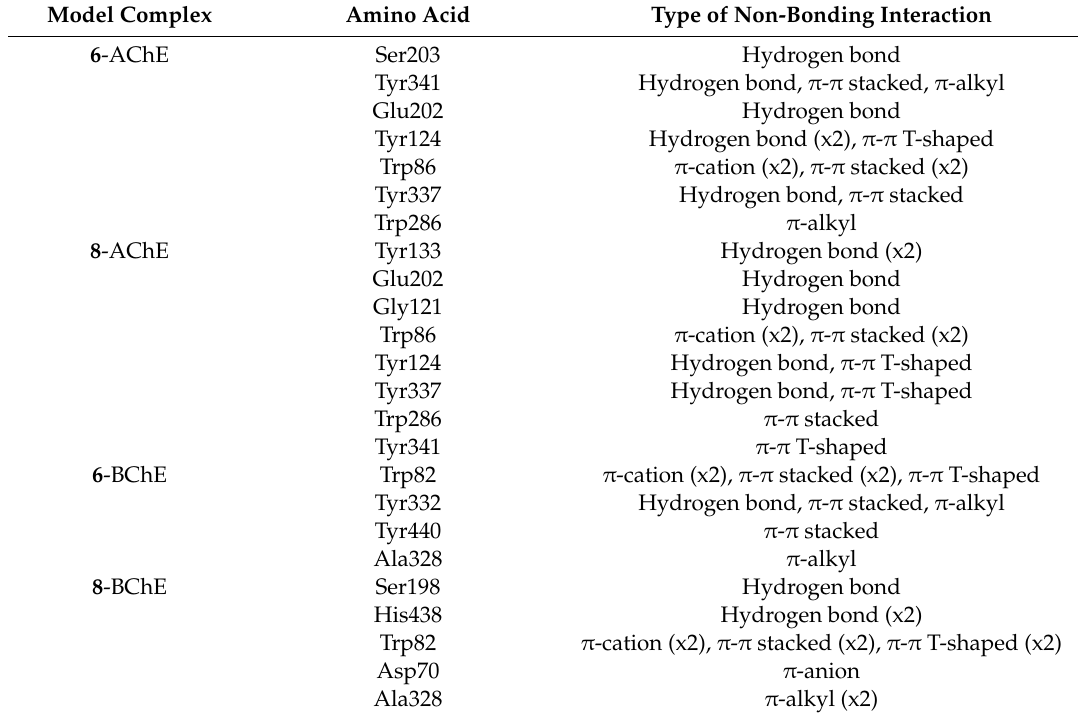
Table A1. List of predicted non-bonding interactions for modelled